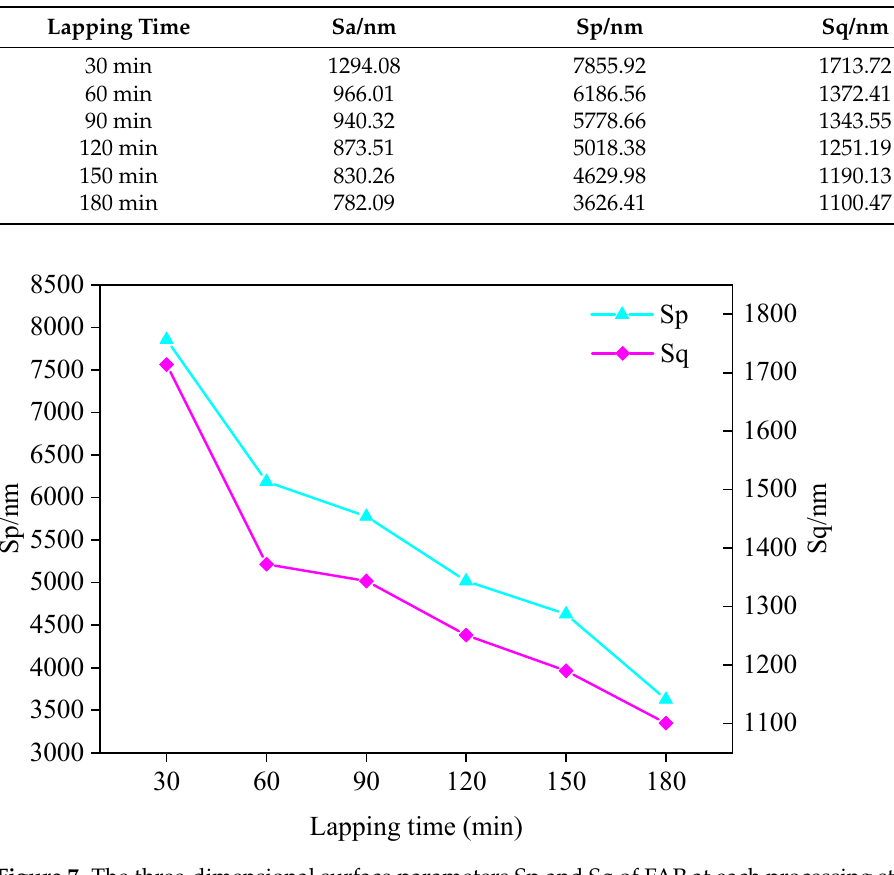
Figure 9. Three-dimensional surface morphology of the FAP in different processing stages. Note: ( a ) Lapping time 0–30 min; ( b ) lapping time 30–60 min; ( c ) lapping time 60–90 min; ( d ) lapping time 90–120 min; ( e ) lapping time 120–150 min; ( f ) lapping time 150–180 min. 4.3. Relationship between Surface Roughness of Workpiece after Wear and the Energy Proportion of Wavelet Packet In order to observe the micro cutting performance of FAP surface abrasive particles and the surface roughness of workpiece at different machining stages more intuitively,